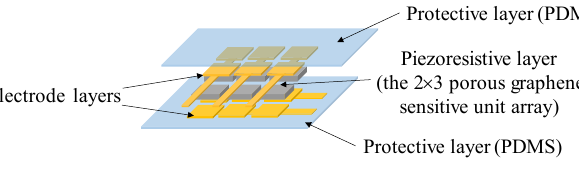
Figure 1. Structure of the porous graphene tactile sensor array.